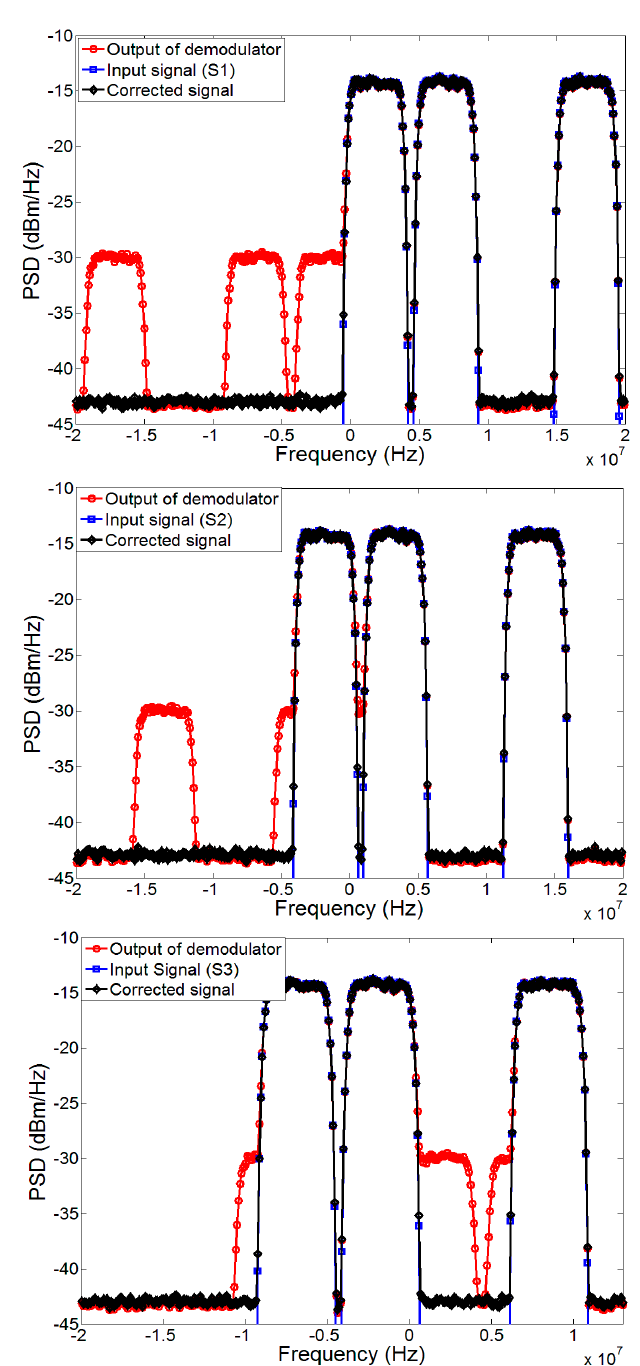
Figure 7. Power spectral density (PSD) of WCDMA 1101 (S1, S2 and S3) signals before and after correction, using the proposed method for g = 0.92 dB, g’ = 0.5 dB and θ = − 6 degrees, θ ’ = − 2 degrees under 20 dB SNR.